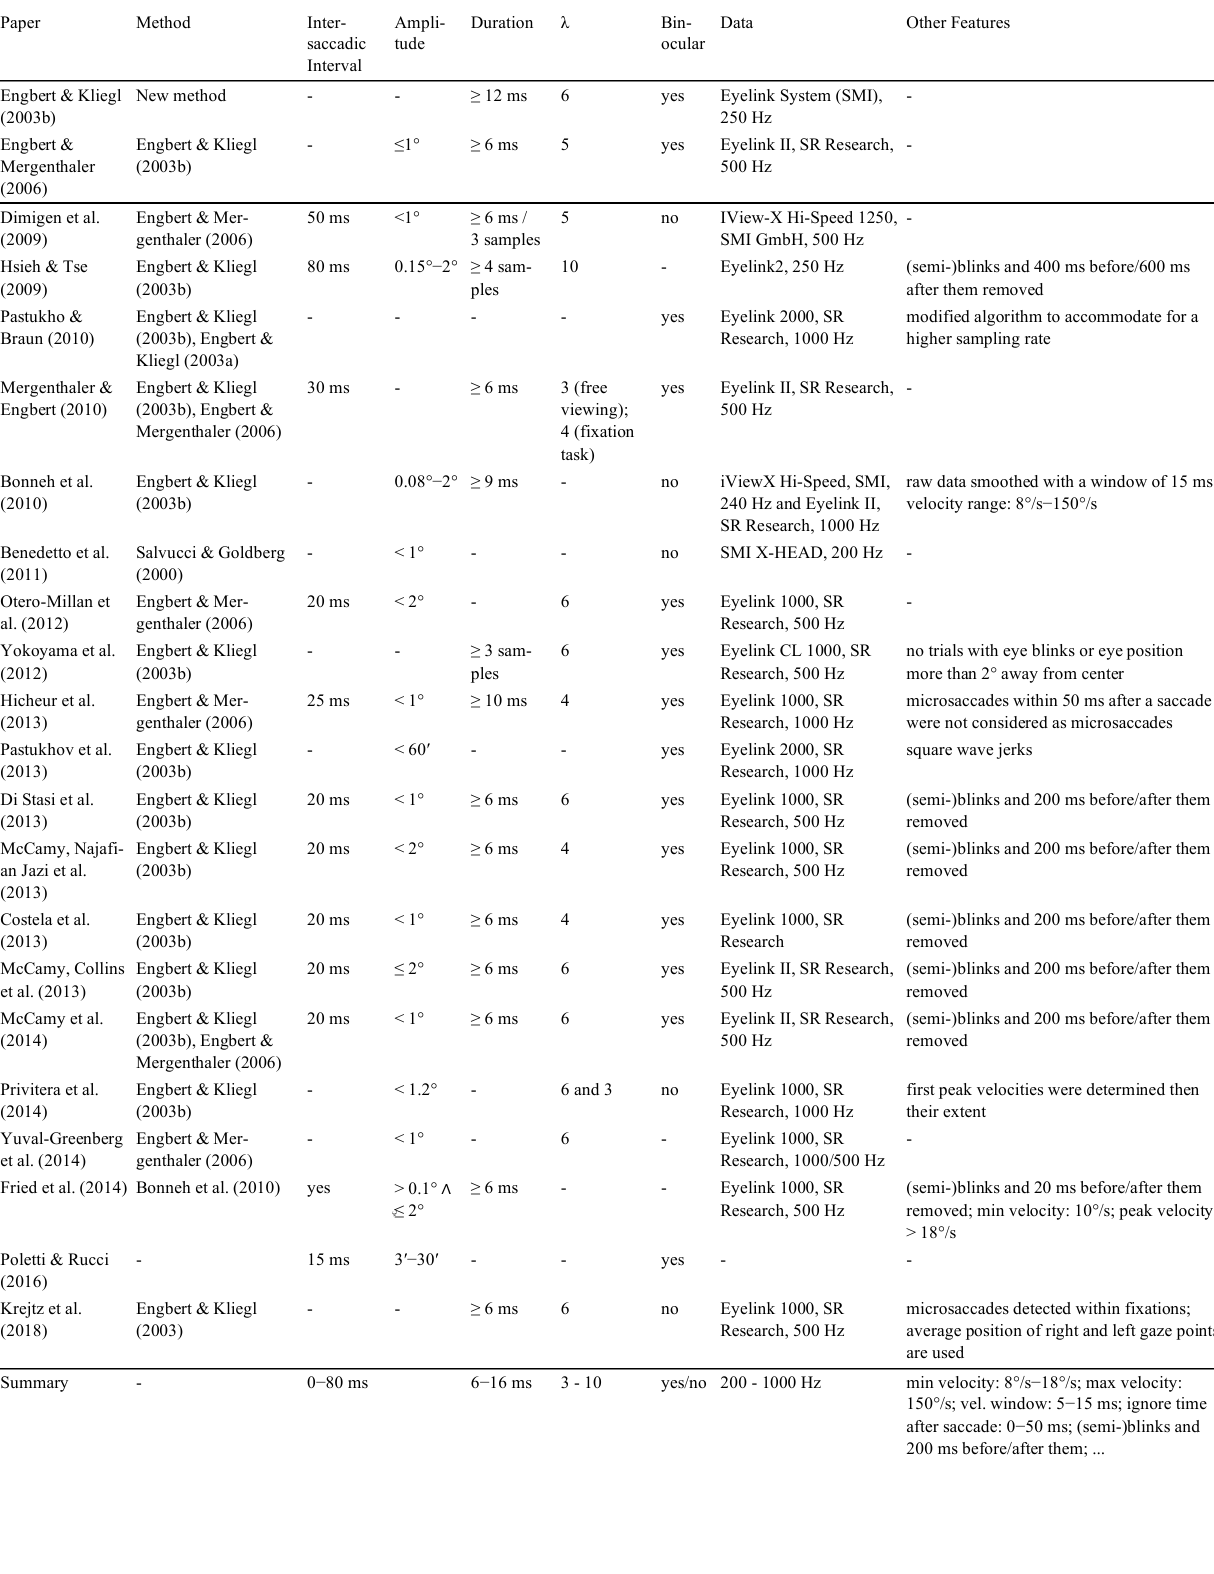
Table 1. Comparison of microsaccade filters used in different research projects in 2009–2018. Engbert and Kliegl (2003b) and Engbert and Mergenthaler (2006) are added for reference and the last row shows a summary of parameter